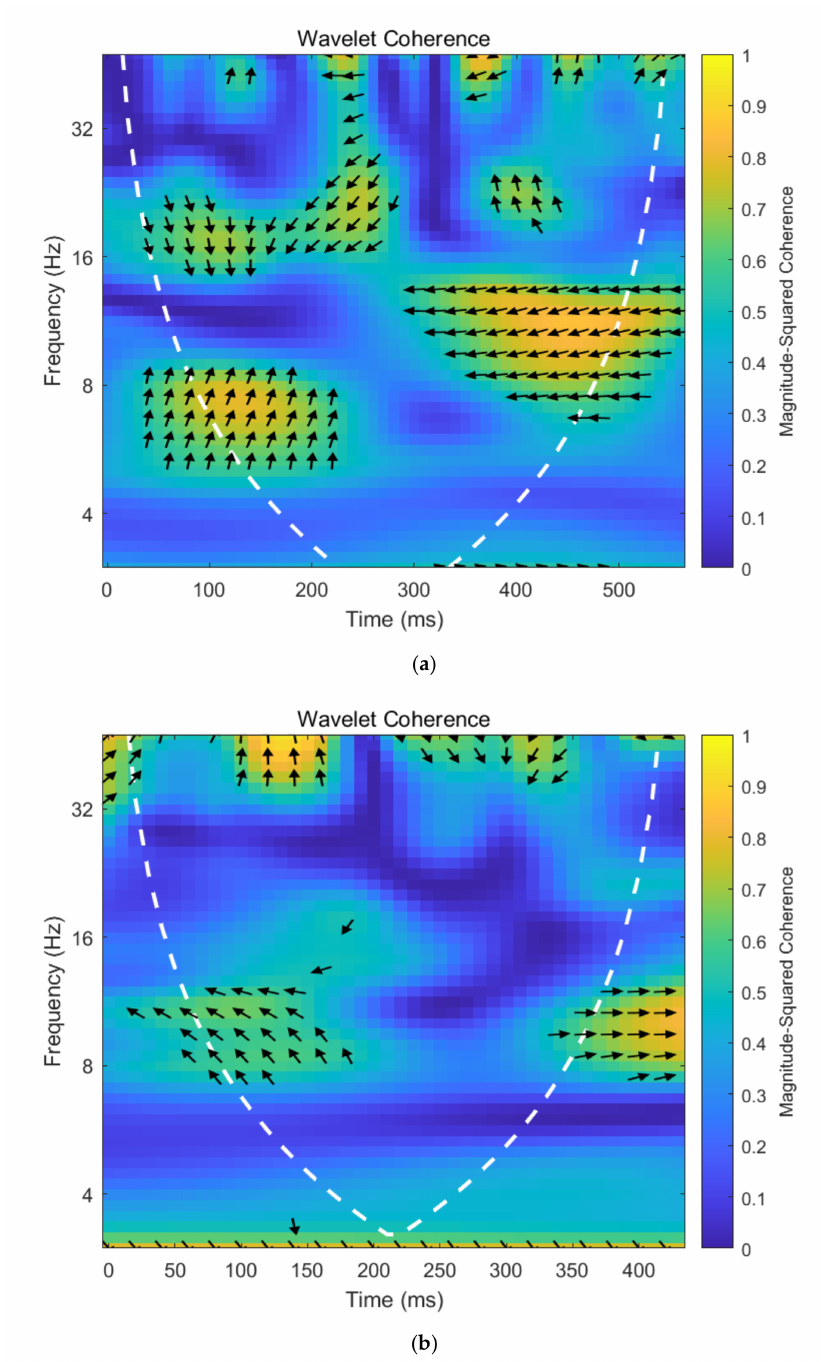
Figure 7. The wavelet coherency map between aggregate demand shocks and investor sentiment under different trends of crude oil price. ( a ) exhibits the wavelet coherency map of aggregate demand shocks and investor sentiment under rising trend in crude oil prices, while ( b ) presents the wavelet coherency map of aggregate demand shocks and investor sentiment under down trend in crude oil prices. The color of a region from blue to yellow implies the coherence correlation between aggregate demand shocks and investor sentiment become greater. The arrows show the correlation and lead–lag relationship between aggregate demand shocks and investor